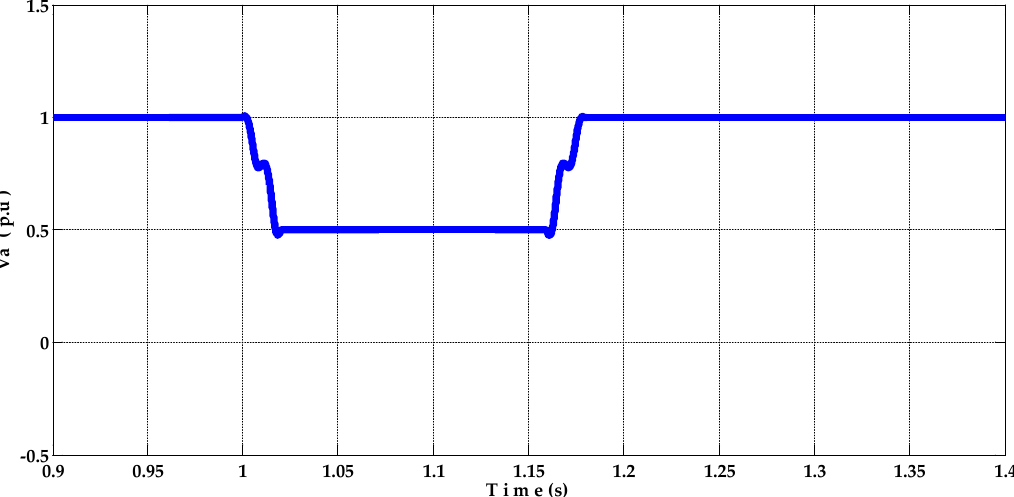
Figure 20. DC link voltage of BDFRG with and without the proposed crowbar under single-line to ground fault occurrence.